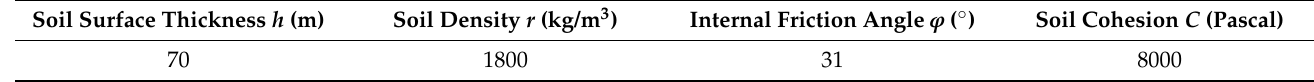
Table 4. Slope related parameters.